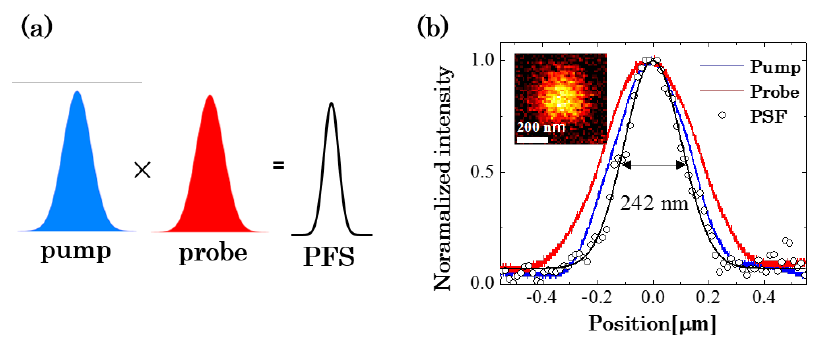
Figure 3. Spatial resolution in the lateral plane: ( a ) Conceptual diagram of point spread function (PSF) in pump probe microscopy. PSF is given by the product of pump and probe intensities at the focal. ( b ) Intensity profiles of pump (blue) and probe (red) beams in the lateral plane as measured using a knife edge method. The lateral PSF is obtained by imaging a 20 nm gold nanoparticle (inset). The wavelengths of the pump and probe beam were 488 nm and 640 nm, respectively. The numerical aperture of the objective lens is 0.95. For the sample preparation, gold nanoparticles are dispersed in a polyvinyl alcohol (PVA) film on a glass slide. The wavelength of the pump beam overlapped the absorption spectrum of the gold nanoparticles due to the plasmon resonance peak at 524 nm.